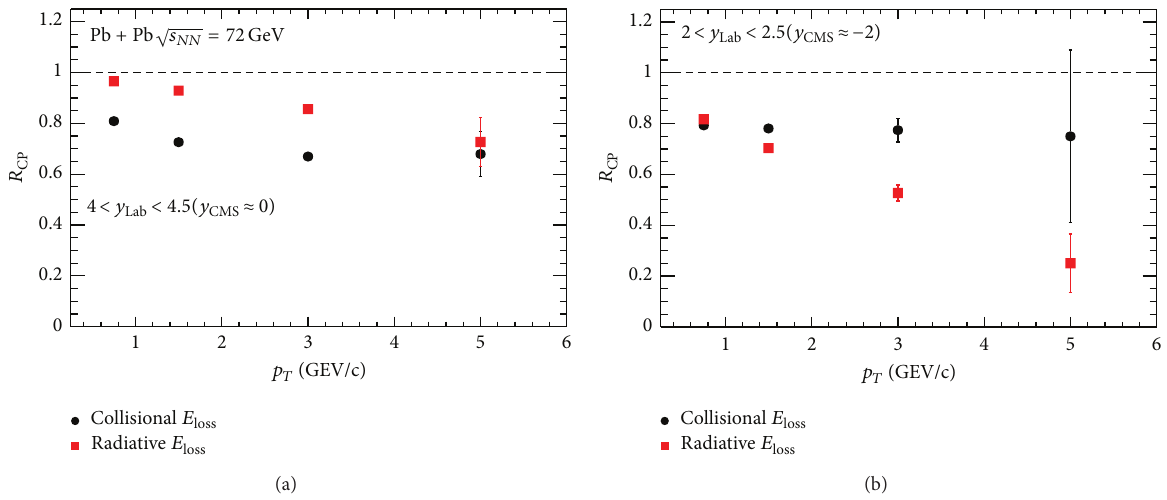
Figure 9: Expected statistical uncertainties of nuclear modification factor 𝑅 CP for 𝐷 0 meson in Pb + Pb collisions at √𝑠 𝑁𝑁 = 72